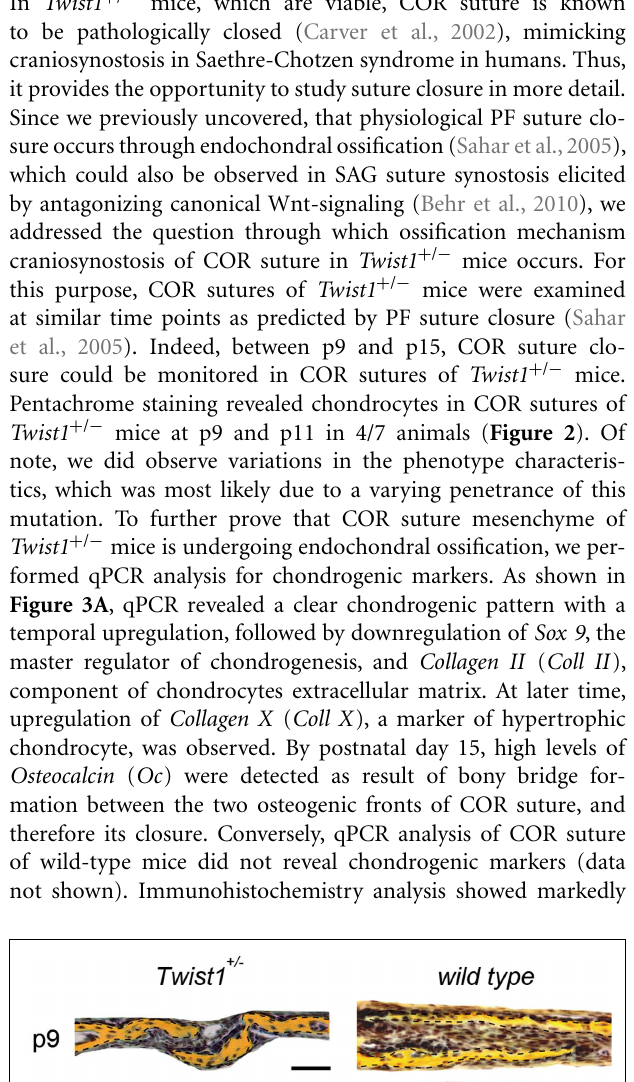
(Sigma-Aldrich,St. Louis,MO,USA) at 37˚C for 10 min. Antibod-